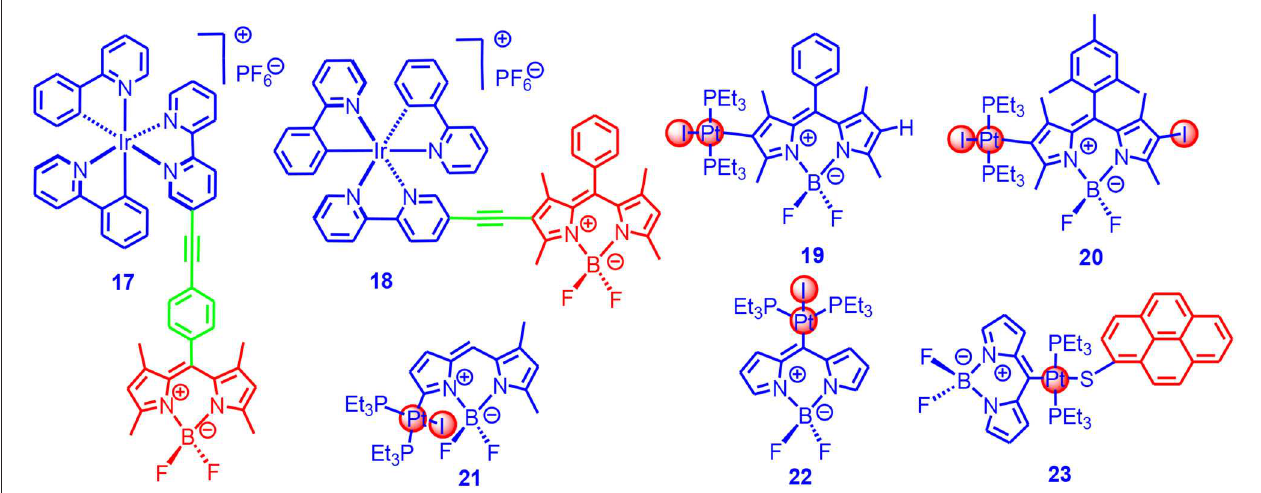
FIGURE 6 | Ir(III)(ppy)(bpy) complex (17, 18) contains Bodipy chromophores via conjugated and non-conjugated linkers and σ -Pt-BODIPY complexes (19–23) with the Bodipy carbon directly